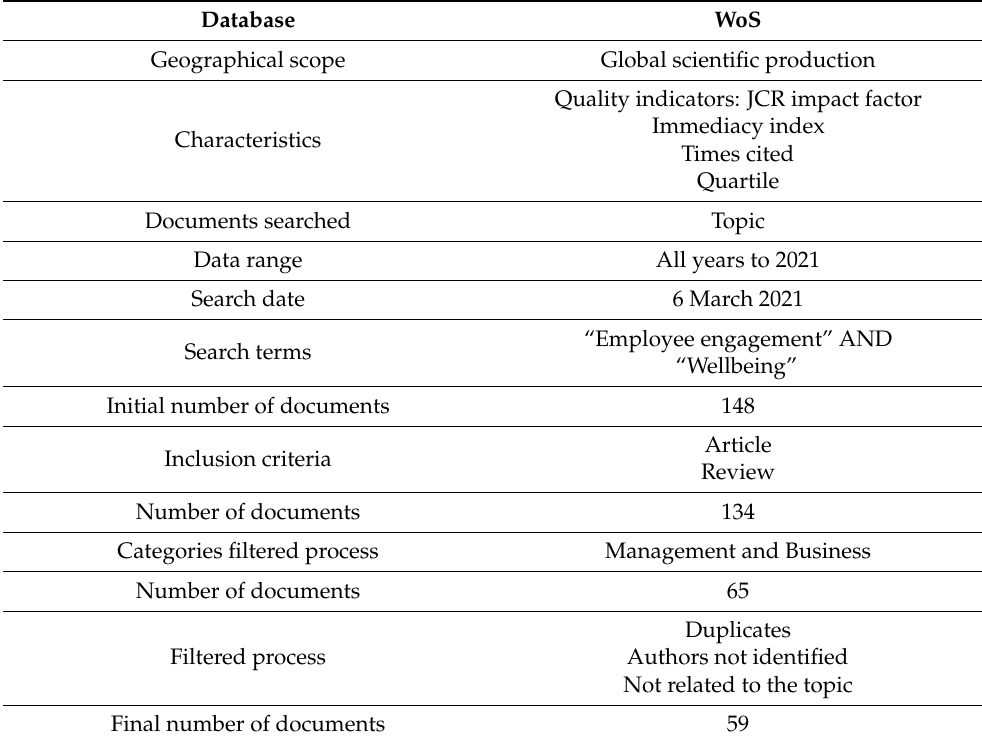
Table 1. Search protocol and